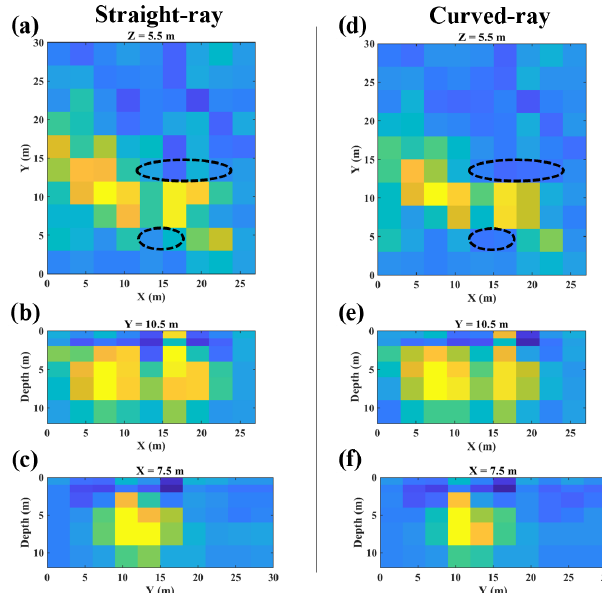
Figure 10. SWT inversion results. Straight-ray SWT results are shown at (a) 5.5m depth, (b) Y = 10 . 5m, (c) X = 7 . 5m, and the results of the curved-ray for the same slices are displayed in pan- els (d) – (f) . The black dashes mark the blocks in which the VS from the straight-ray and curved-ray are considerably different.